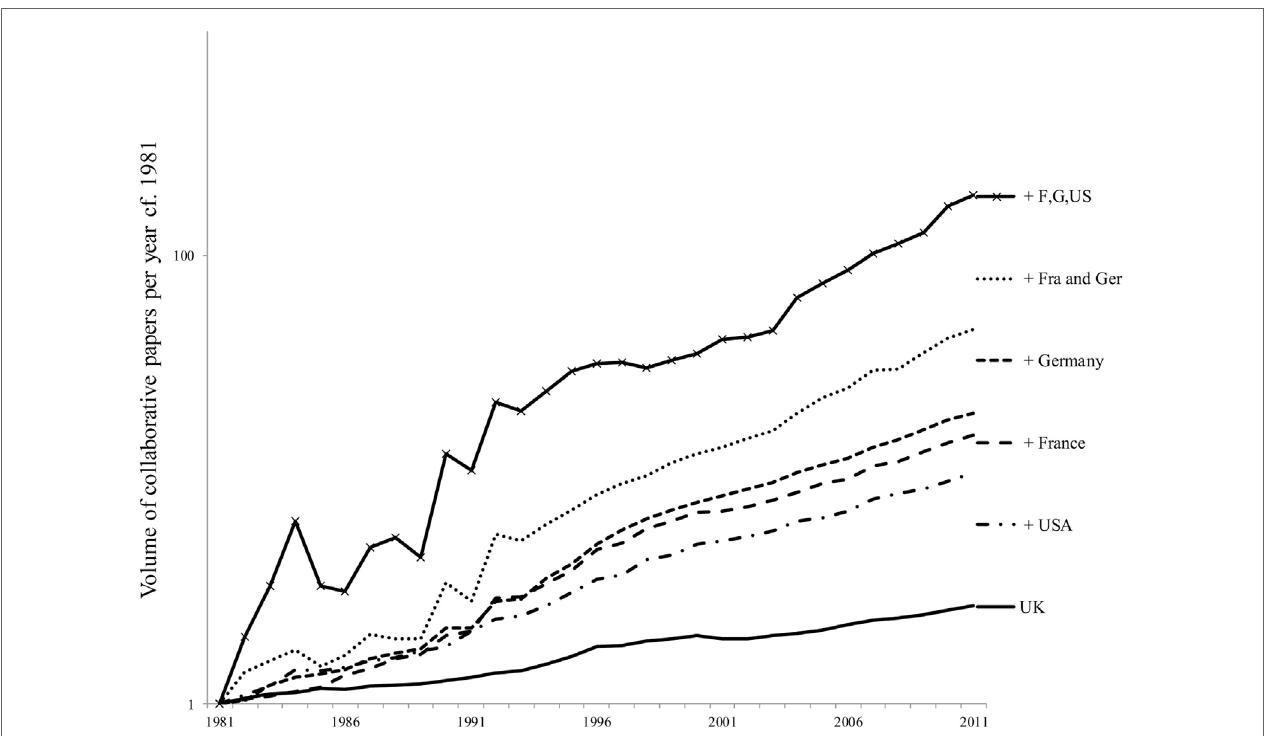
FigUre 2 | Increase in the relative frequency (log scale) of papers for the UK with co-authors from frequent partner countries [USA, Germany (Ger, G), France (Fra, F)]. Data shown with most frequent collaborators both singly and in collaboration; other countries may also co-author on any or all of these papers. The data show that the increase in collaboration with multiple partners is more rapid than the increase in output as a